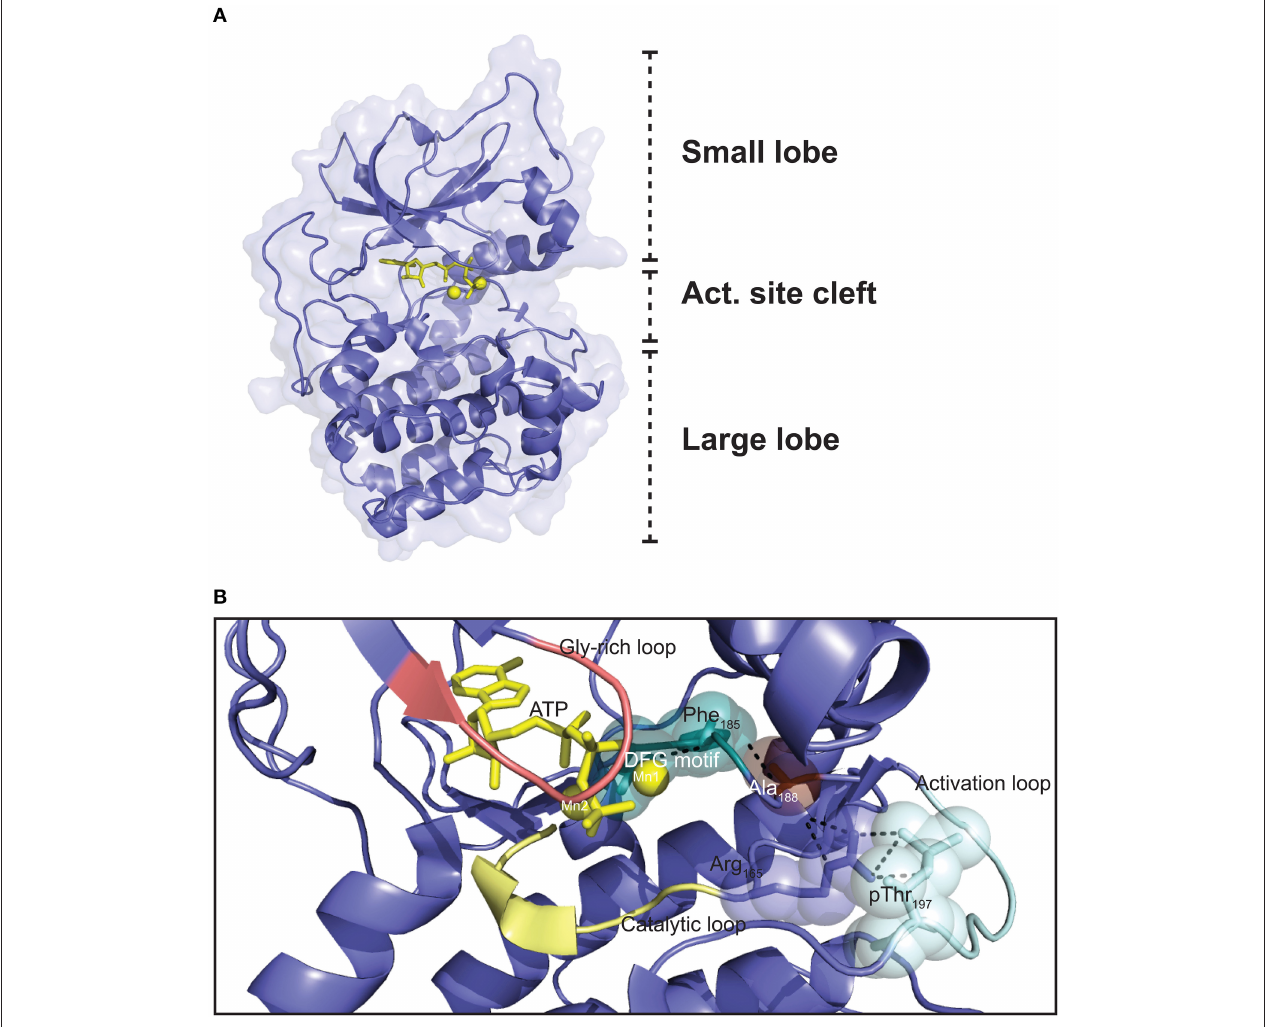
FIGURE 3 | Three dimensional structure of the PKA C subunit. (A) The C subunit is composed of a small lobe, large lobe, and an active site cleft with a binding site for an ATP molecule (yellow sticks) and two Mg2 + ions (yellow spheres). The figure is based on the experimental structure with Protein Data Bank (PDB) identifier 3FJQ (169). (B) Schematic representation of the active site cleft of PKA C α 1. Motifs and residues described in the text are indicated. Dashed lines indicate the chain of interactions leading from pThr197 to Phe185 in the DFG motif when the enzyme is in the active conformation. The structure is solved with Mn 2 + as the divalent cations, although Mg 2 + is thought to be the most relevant biological chelating agent (170). ATP and the Mn 2 + ions are shown in yellow, and the DFG motif (teal), Gly-rich loop (salmon), catalytic loop (yellow), and activation loop (cyan) are also highlighted. PDB identifier 3FJQ (169).